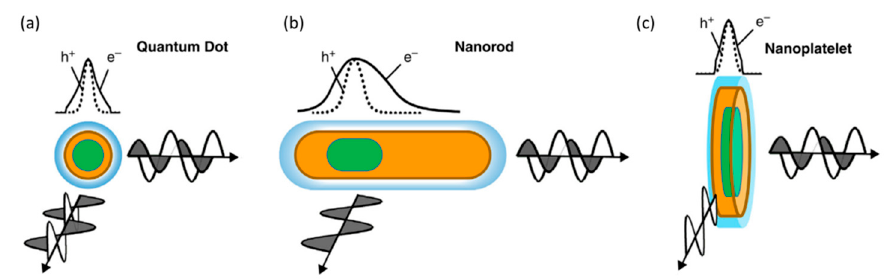
Figure 16. Illustrations of nanocrystal structures show wave functions of electrons and holes, and depictions of emission light polarization. Reproduced with permission from [199]. Copyright Elsevier,